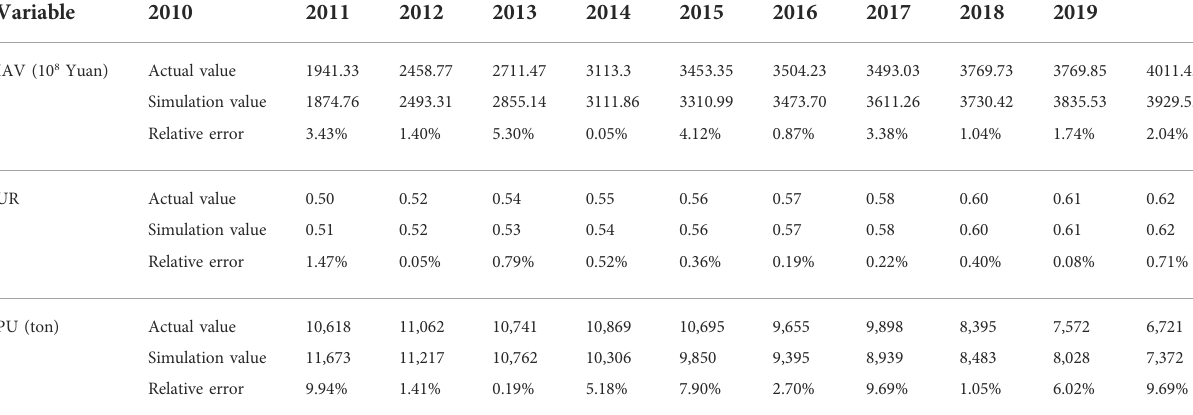
TABLE 4 Error rate of the simulation value and historical data in 2010 –